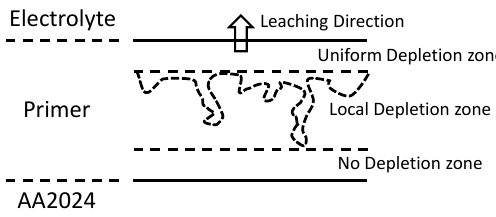
Figure 15. Model of leaching from the Li 2 O 3 ‐ inhibited primer based on the observations for 500 h exposure to NSS. Leaching appears to occur both uniformly as well as locally. The uniform depletion appears to be associated with changes in coating, whereas the local depletion appears to be associated with selective removal of Li 2 O 3 particles.